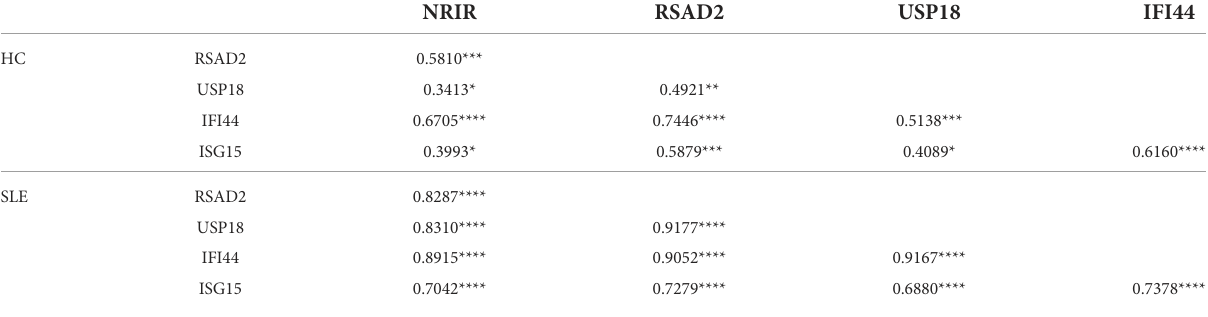
TABLE 3 Correlation coef fi cients among 5 ISGs in the HC and SLE